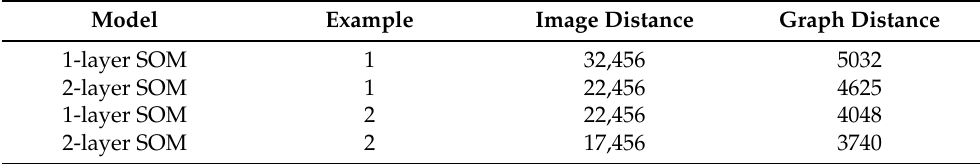
Table 3. Table of the results of the different distance metrics of the algorithms used.